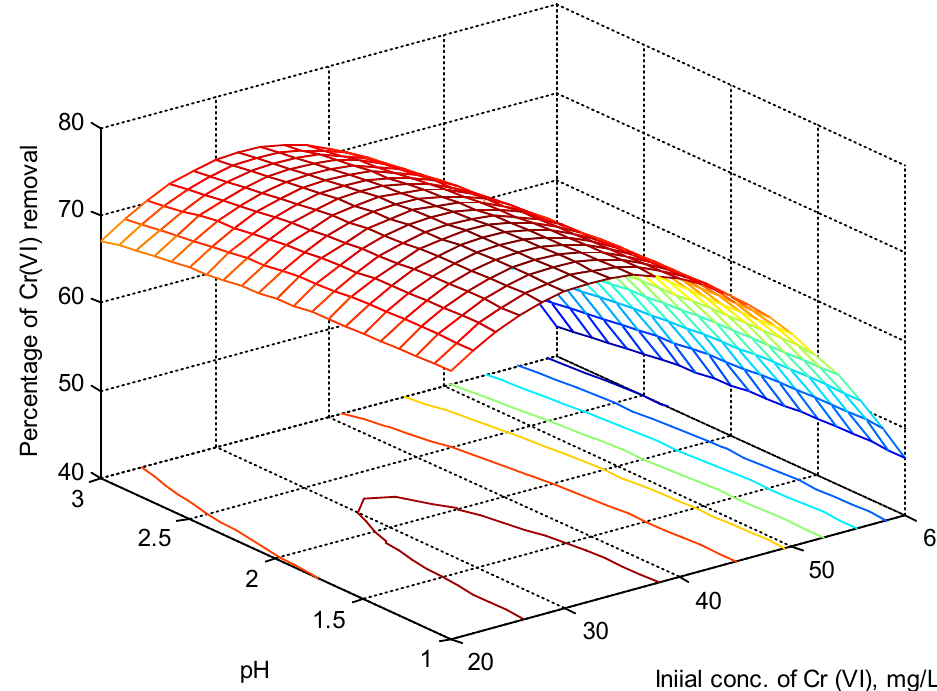
Figure 5. Effect of interaction between initial concentration and pH on removal of Cr (VI) (mixed adsorbent dosage at 12.31 g/L).